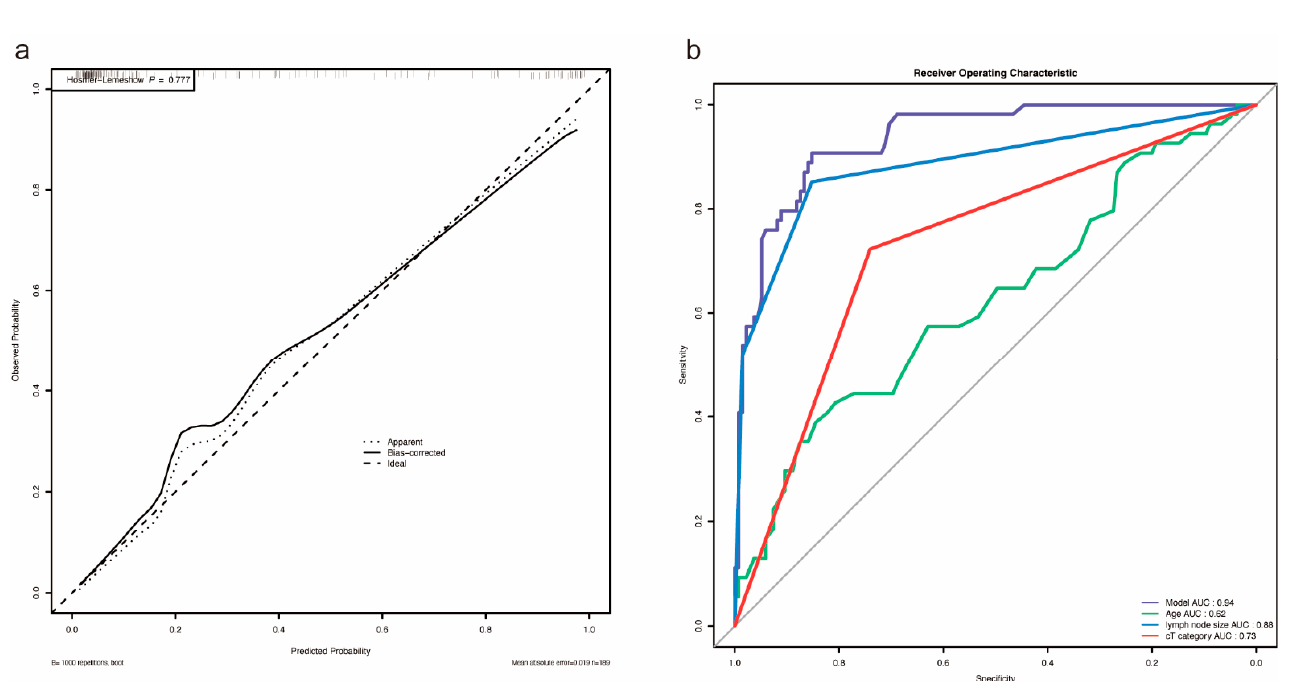
Figure 2. Nomogram of patients for predicting the risk of lymph node metastasis. Total score was 6.9, and the corresponding probability of lymph node metastasis was 97.5%. The asterisks repre- sented the statistical p value (* p < 0.05; ** p < 0.01; *** p < 0.001).